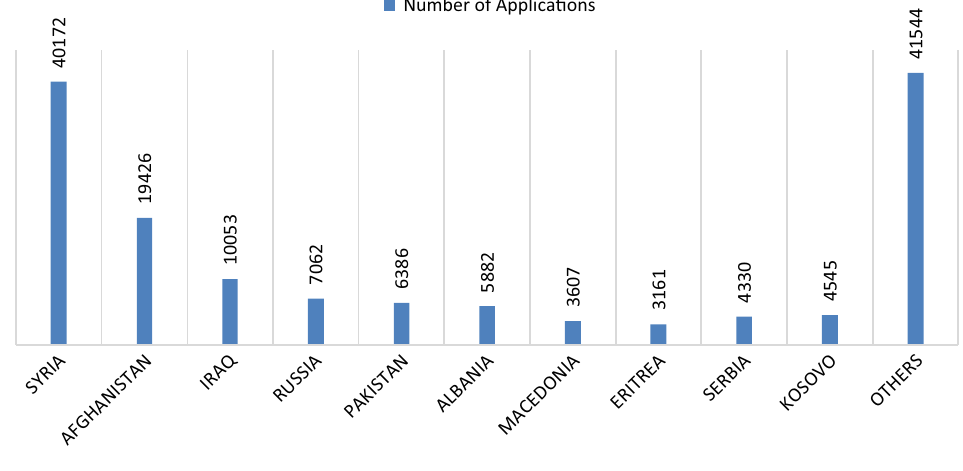
Figure 2. Countries of origin in total in 2017. 101